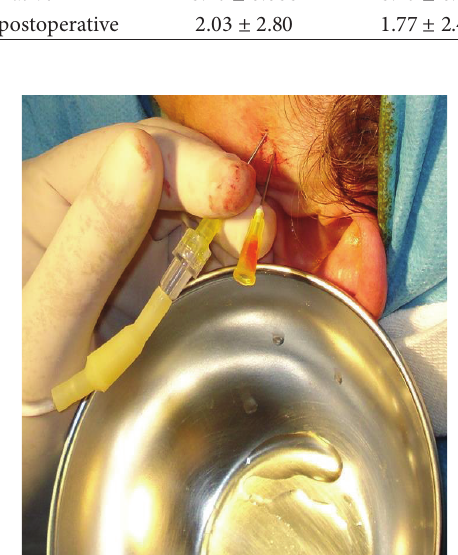
Figure 3: Clinical procedure: with the mouth widely open and the mandible in protruded position, introduction of the needles and injection of saline to fill the joint space and establish the flow of the NaCl solution are